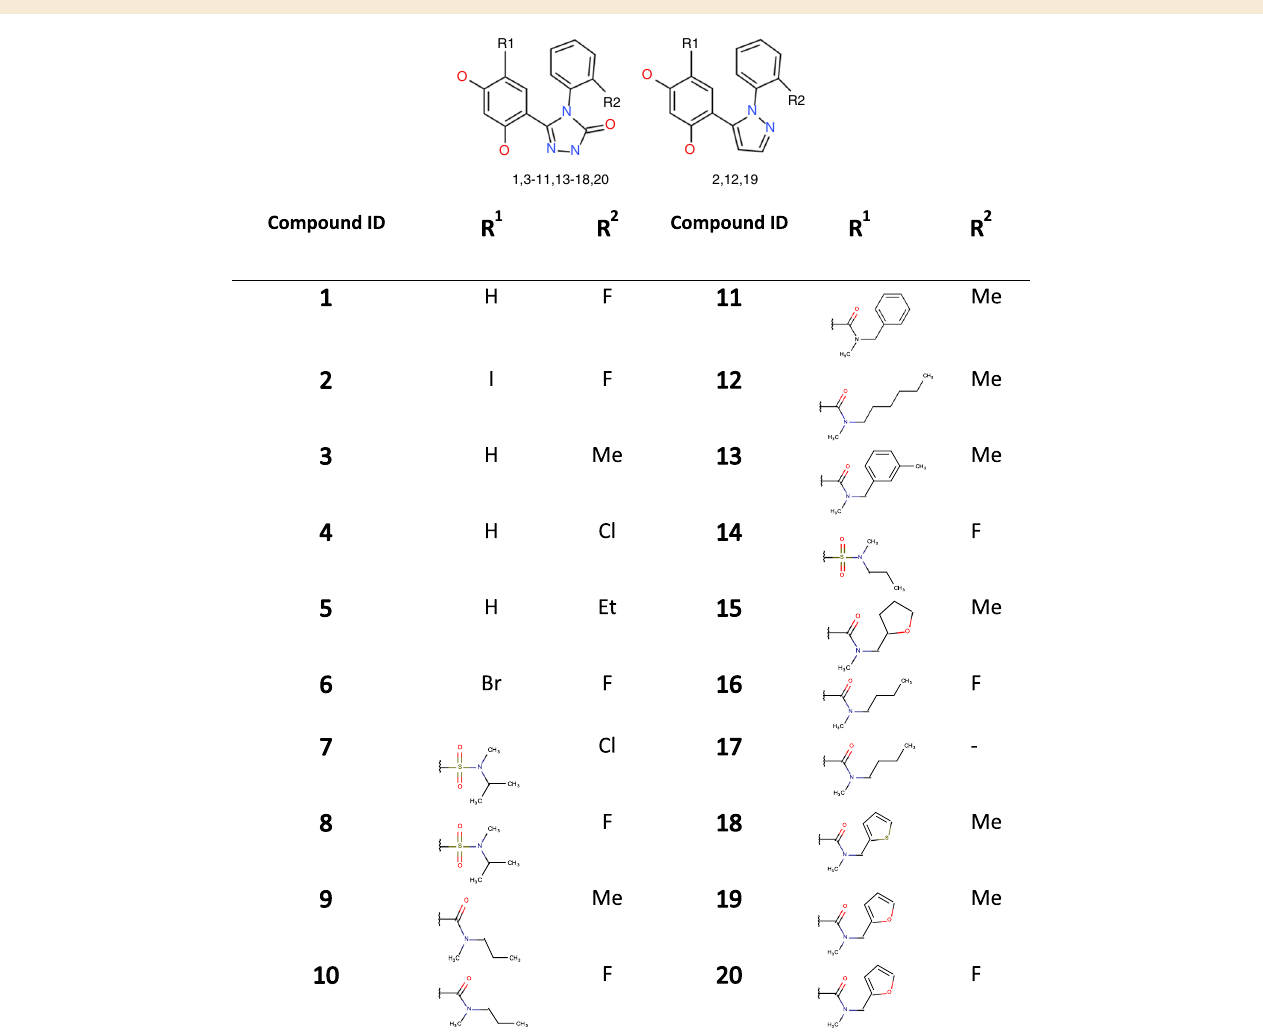
Table 1 Chemical structure of compounds 1 – 20 with R 1 and R 2